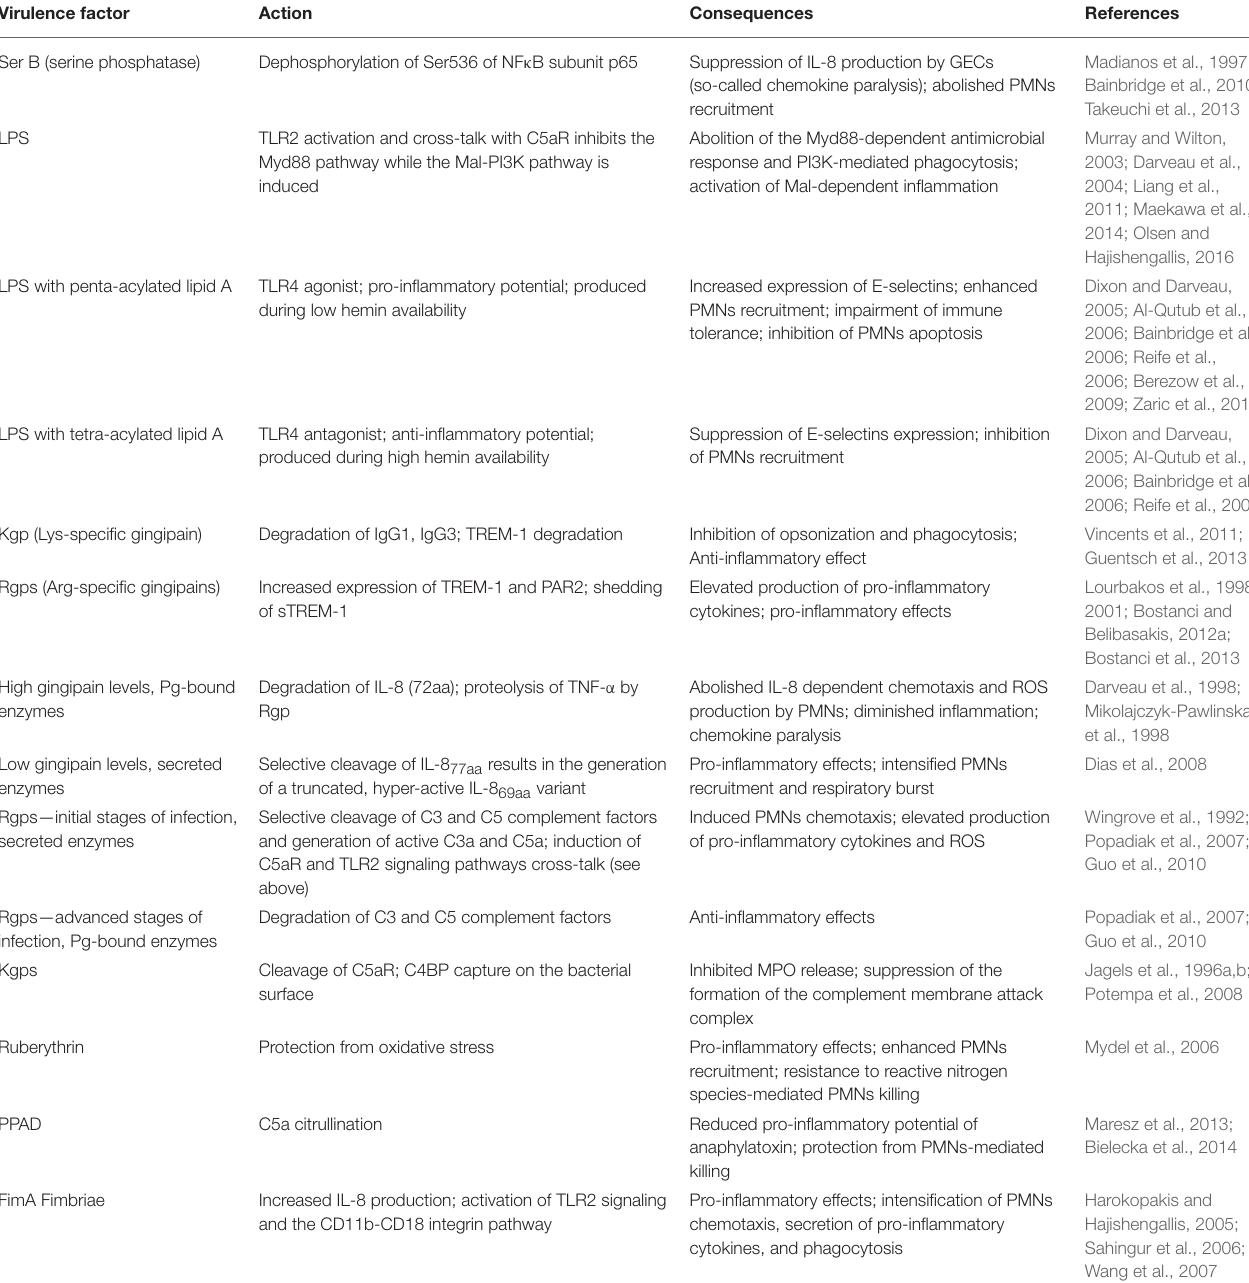
TABLE 1 | P. gingivalis virulence factors involved in the manipulation of neutrophil immune